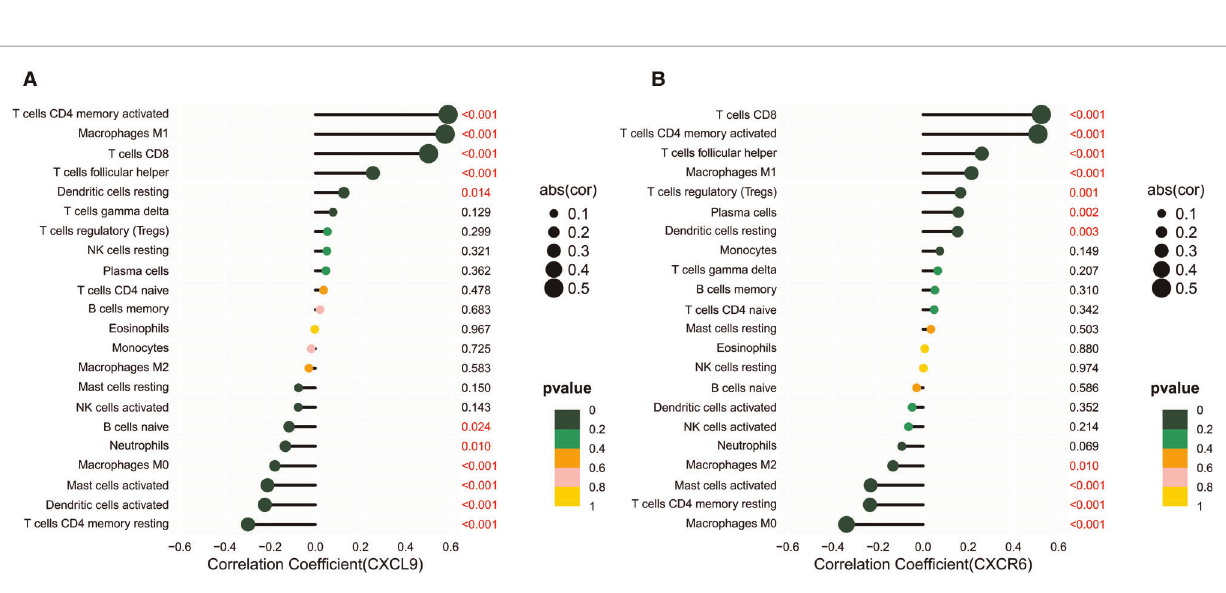
FIGURE 8 | Correlation between the HUB genes with TICs. ( A,B ) Lollipop plots showed correlation of CXCR6 and CXCL9 expression with 22 types of TICs. The size of the lollipop illustrates the level of correlation, and the color of the lollipop indicates the p